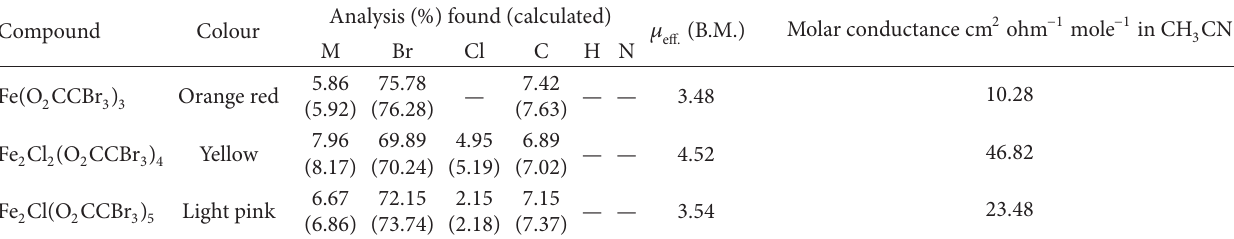
T 2: Physical and analytical data, molar conductance, and magnetic moments of